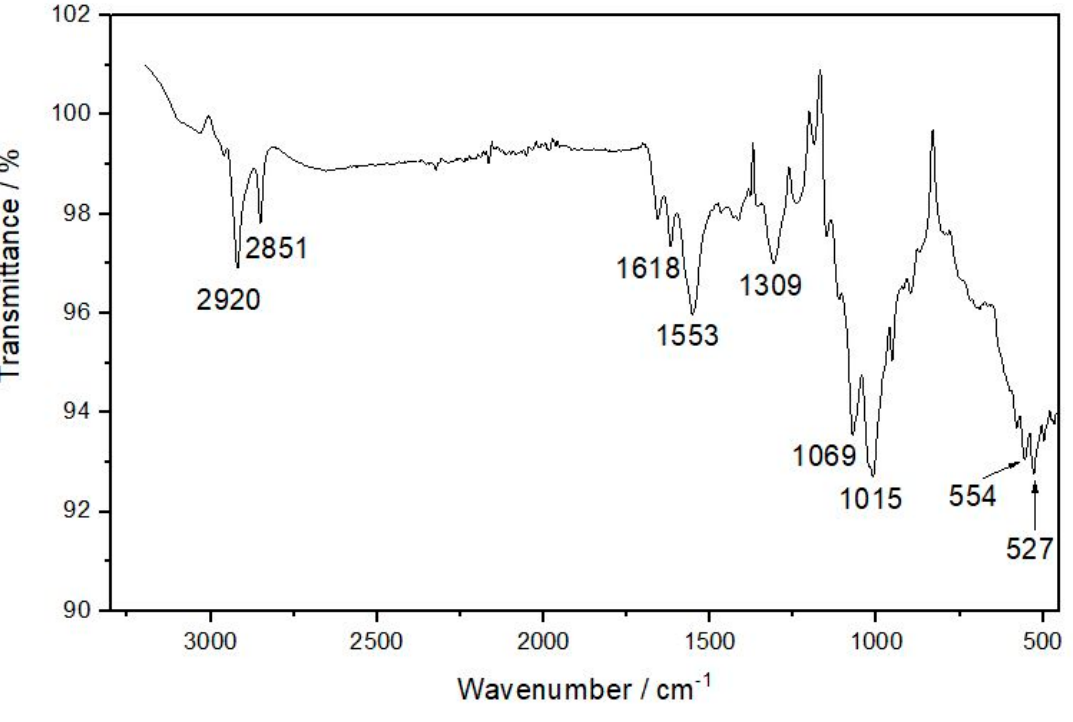
Figure A3. Chitosan infrared spectrum.